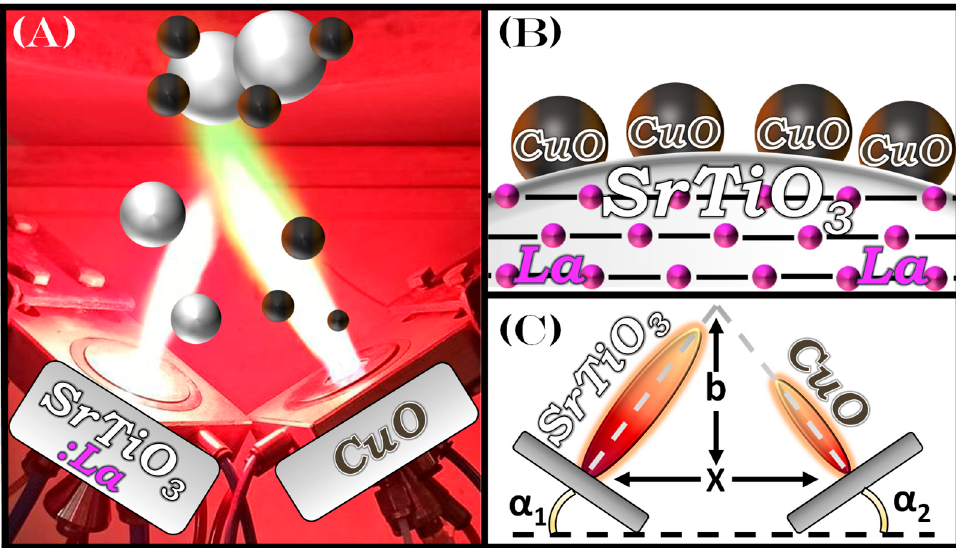
Figure 1. ( A ) Description of the Double-Nozzle FSP (DN-FSP) set-up, with the SrTiO 3 formation in the left-side nozzle and the CuO formation in the right-side nozzle. ( B ) Schematic depiction of the structure of the La:SrTiO 3 /CuO particle. ( C ) The geometric parameters for the two nozzles in DN-FSP.